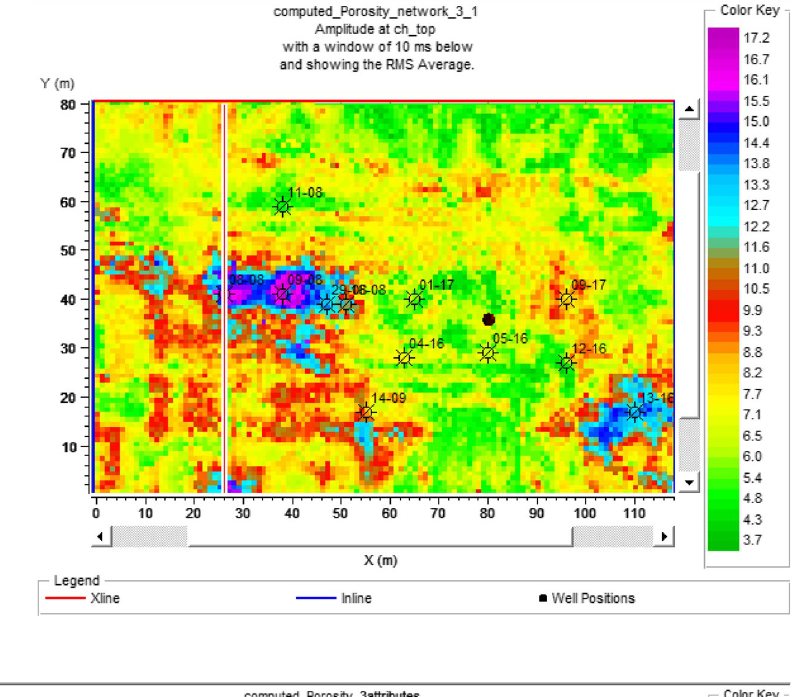
Fig. 42 2D porosity from multi-